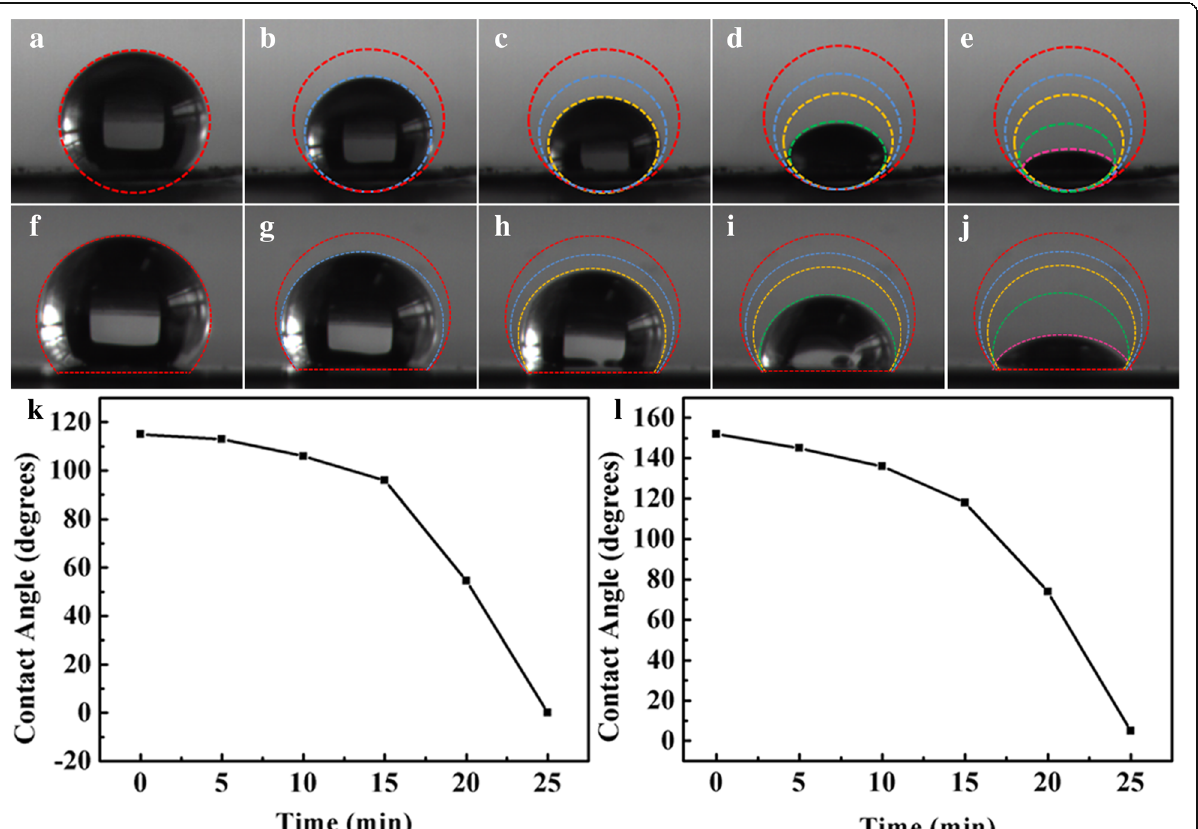
Fig. 6 a – e Images of evaporation process of a droplet of RB aqueous solution dripped onto superhydrophobic surface. f – j Images of evaporation process of a droplet of RB aqueous solution dripped onto AgNWs@AgNPs surface. k , l Plot of contact angle with different evaporating times at 0,